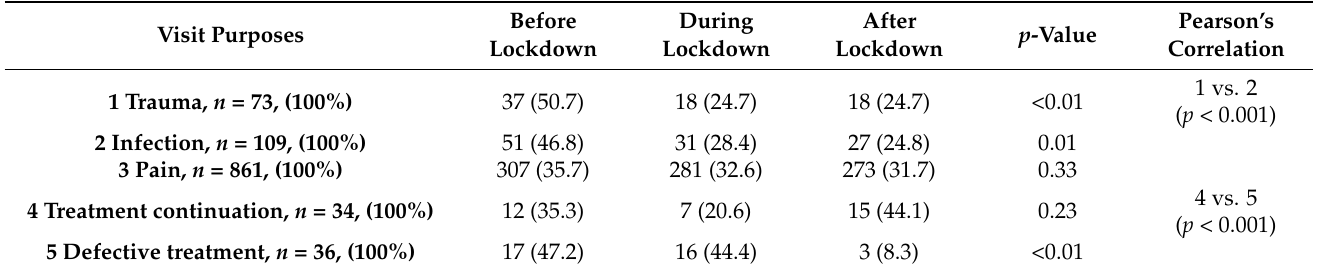
Table 2. Comparison and correlation among the purpose of the pediatric patients’ emergency visits before, during, and after the lockdown.